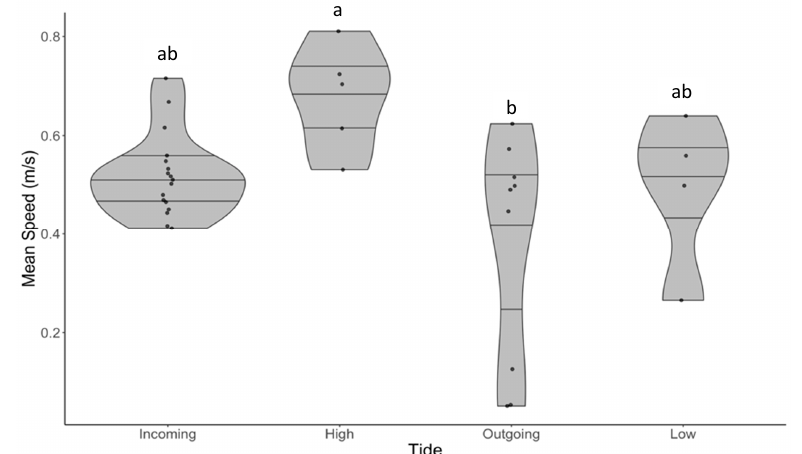
Figure 9. Impact of tide on mean speed (meters per second). Dots represent individual tracks. The lines represent the quantiles. The letters represent the Tukey test results indicating differences between groups.